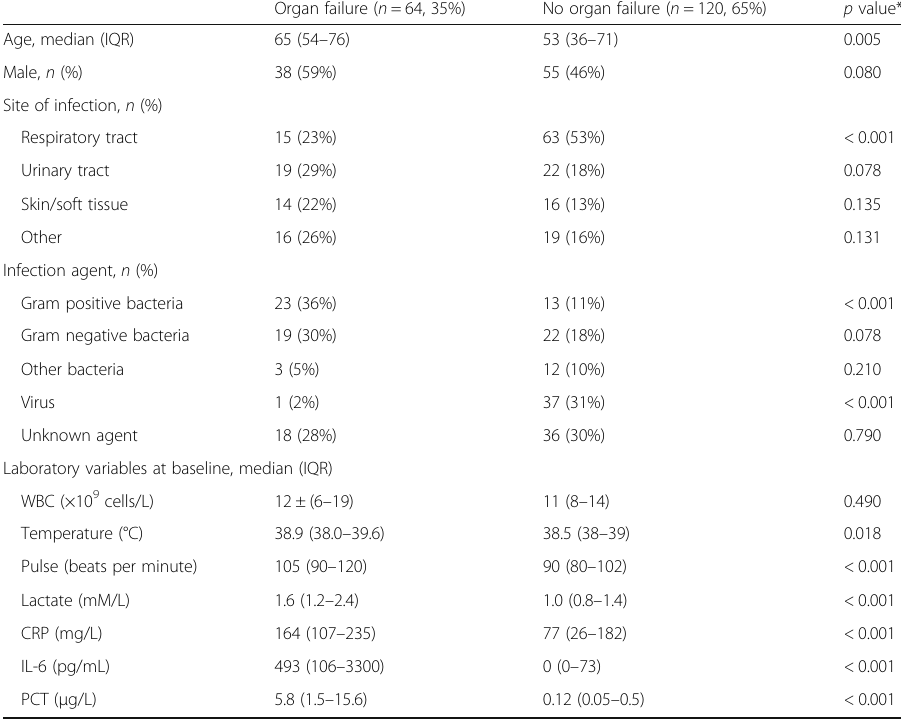
Table 1 Patient characteristics at time of blood sampling (baseline) Organ failure ( n =64, 35%) No organ failure ( n =120, 65%) p